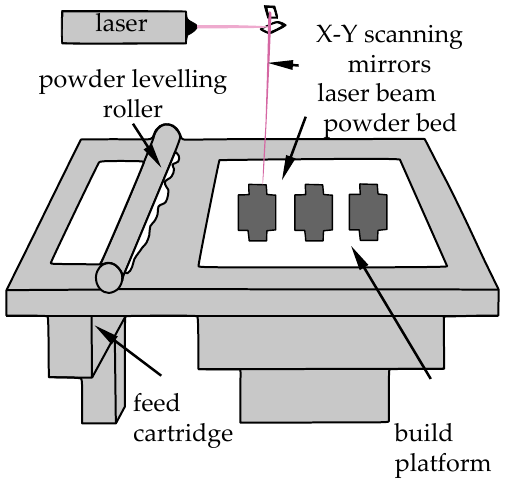
Figure 9. Schematic representation of laser powder bed fusion (based on the work in [30]).